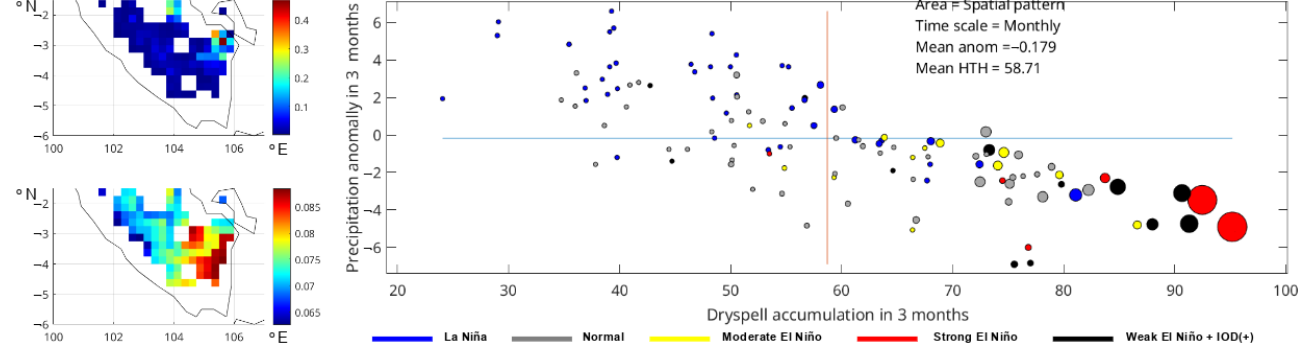
Figure 8. Southern part of Sumatra—spatial graph of hotspots (top) and dry spells (bottom) as well as bubble plot of the monthly fire events for all categories. Blue and orange lines represent average value of respective variables. Size of the bubble represents the number of hotspots for each particular month. Extracted from first mode of SVD with 94.8% of SCF value. Table 6. South Sumatra—difference value of the PDF from years categories.